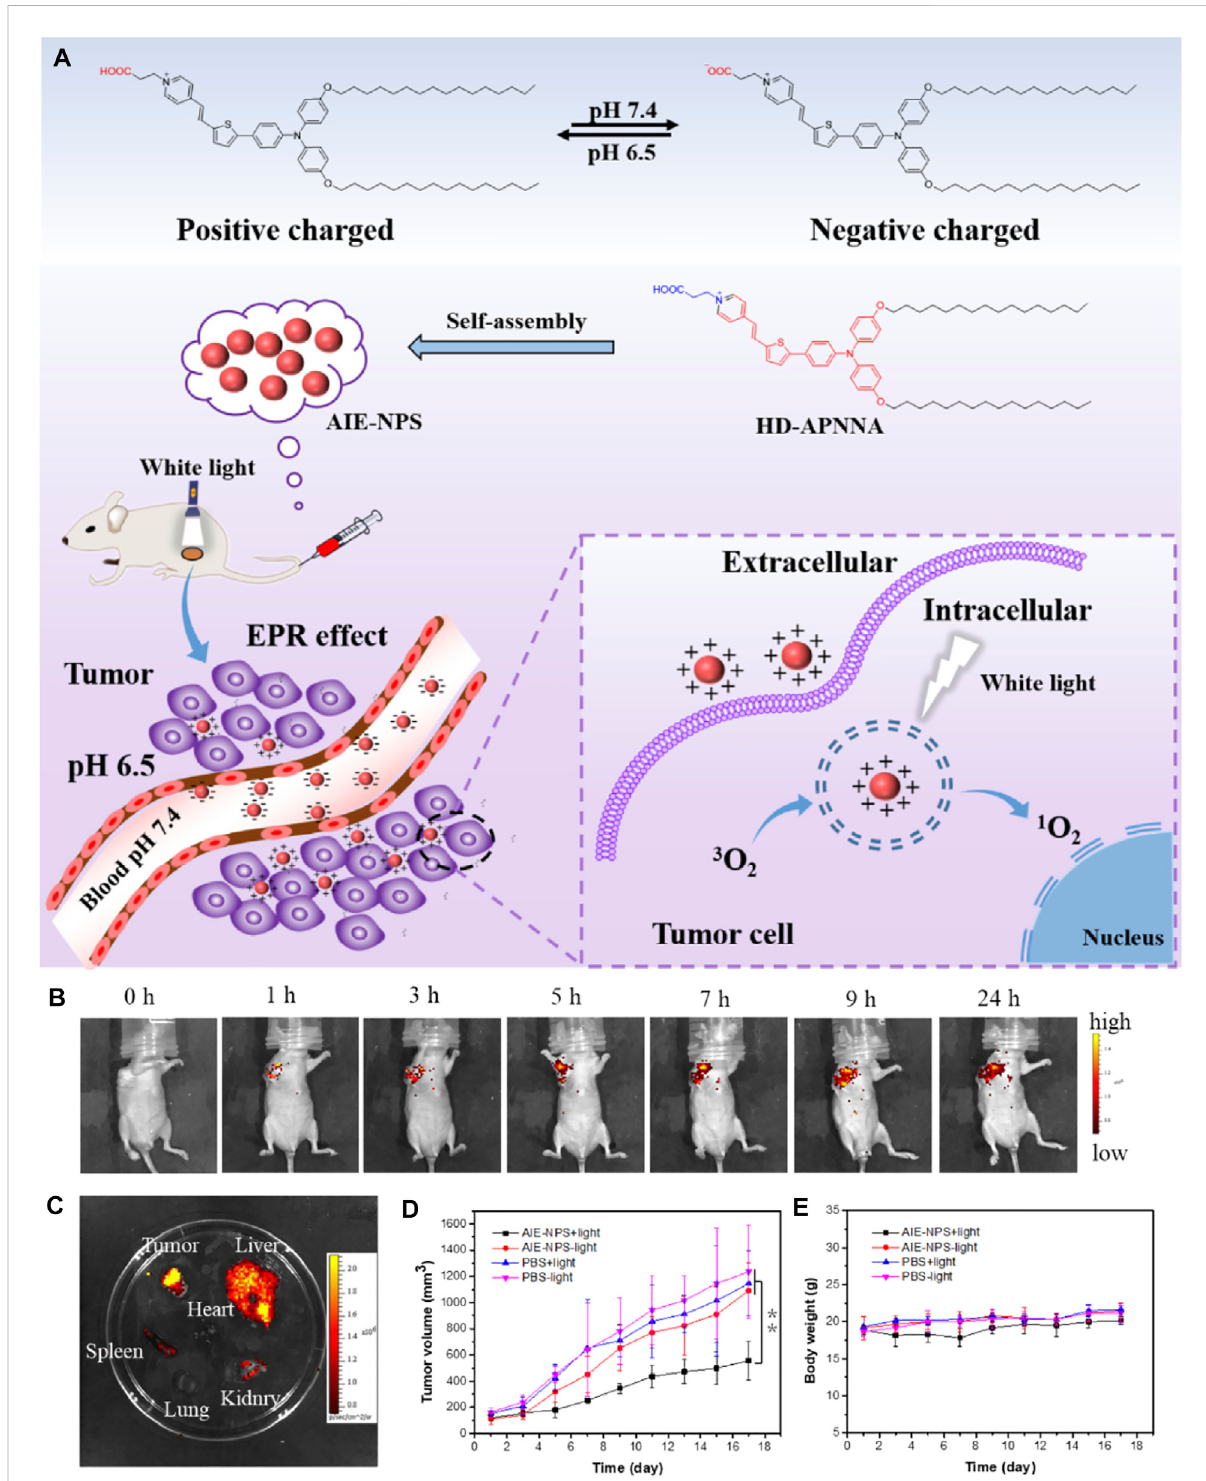
FIGURE 18 (A) Illumination of carrier-free AIE-NPs for tumor photodynamic therapy. (B) In vivo fl uorescence images of HeLa tumor-bearing mice after intravenous injection with the AIE-NPs (1 mg/ml, 50 μ L per mouse). (C) Ex vivo fl uorescence images of organs and tumor at 9 h after intravenous injection of the AIE-NPs. (D) Volume growth curves of tumors at different time points posttreatment in different groups (n = 3, * p < 0.05, ** p < 0.01. (E) Body weight measurement of the mice in each group (Cheng et al.,